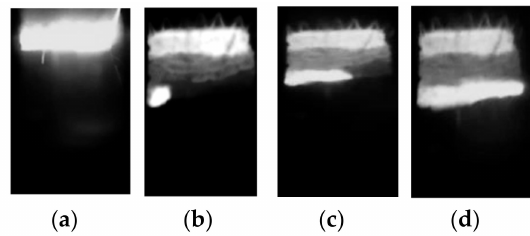
Figure 7. Images of typical spin combustion synthesis: ( a ) ignition; ( b ) spin wave nucleation; ( c ) spin wave motion; ( d ) spin wave completion.